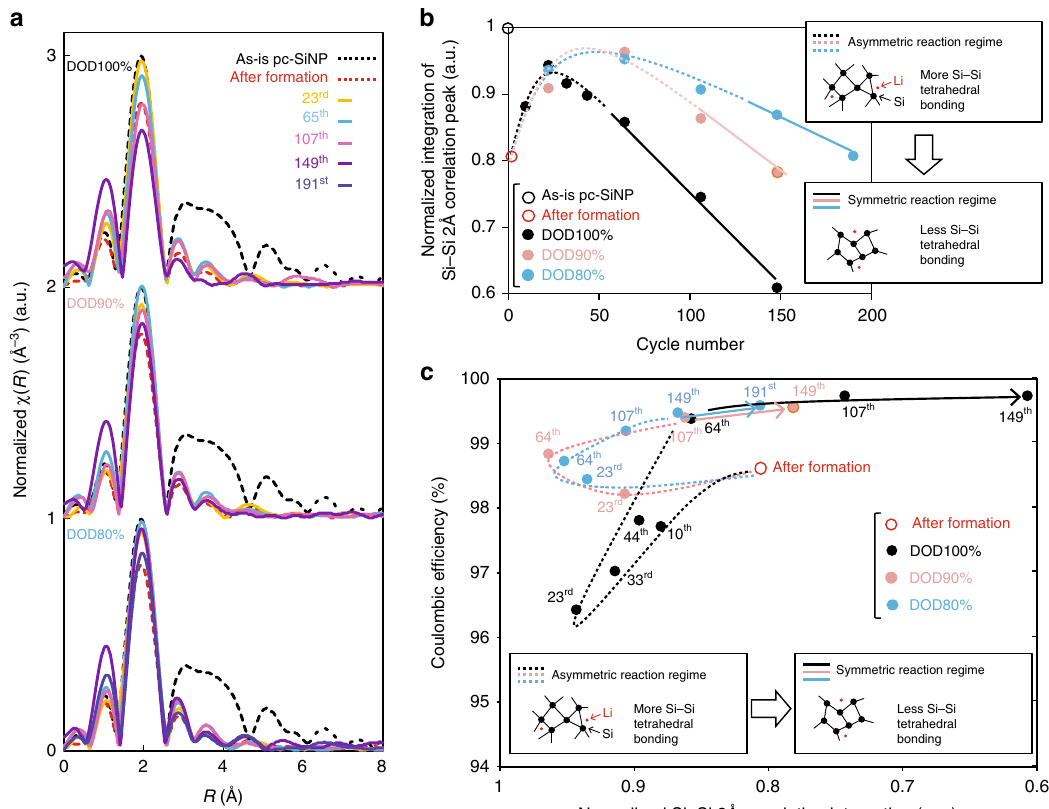
Fig. 8 Ex situ XAFS analyses for delithiated amorphous-Si. a Stacked Fourier-transformed EXAFS pro fi les at Si K-edge for fully delithiated type-A electrodes at 1.5 V over 190 cycles under depth of discharge (DOD)100, 90, and 80%. Black and red dotted lines, and yellow, blue, magenta, purple, and blue solid lines correspond to the as-is electrodes, the electrodes after the amorphization of c-Si, and after the 23 rd , 65 th , 107 th , 149 th , and 191 st cycles, respectively. The pro fi les for the same DOD control are overlaid, whereas those under different DOD controls are stacked with a constant pitch to show the intensity changes more clearly. b Normalized integration of 2 Å Si – Si correlation peak in ( a ), named A (2Å Si – Si) , over 190 cycles for different DOD controls. The as-is type-A electrodes and the electrodes after amorphizing pc-SiNP are shown by black and red empty circles, respectively. The dashed and solid lines indicate the asymmetric and symmetric regimes seen in the Li – Si electrochemical processes (Fig. 3h), respectively. Schematized Si – Si tetrahedral boding environments are illustrated in the chart, suggesting the regime shift from asymmetric to symmetric. c Coulombic ef fi ciency (CE) as a function of A (2Å Si – Si) over 190 cycles for different DOD